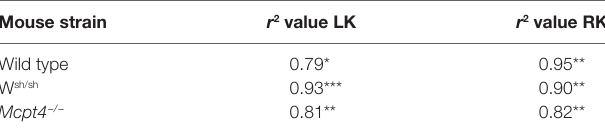
TaBle 1 | correlation coefficient analysis between kidney weights and kidney volumes of left kidneys (lKs) and right kidneys (rKs).